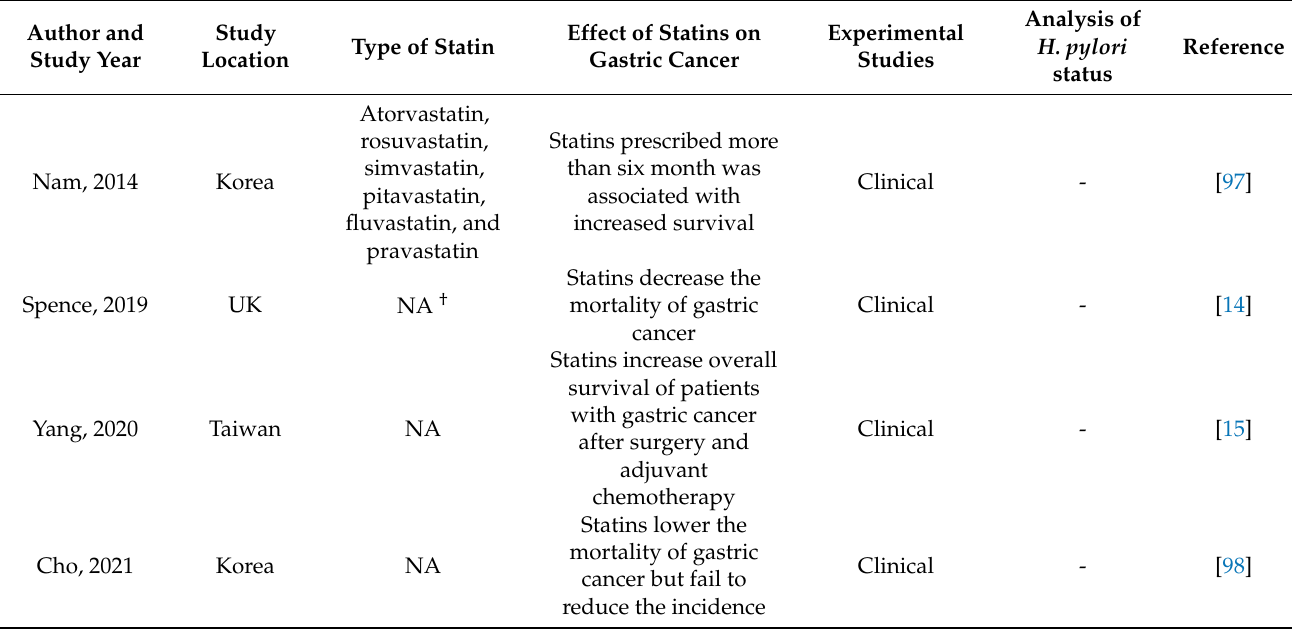
Table 2. The effects of statins on GC